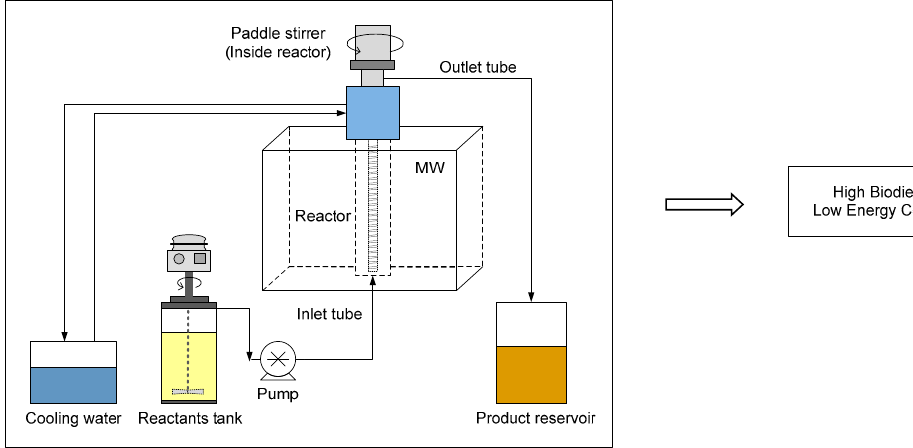
Figure 1. Scheme of the MW equipment used [13].